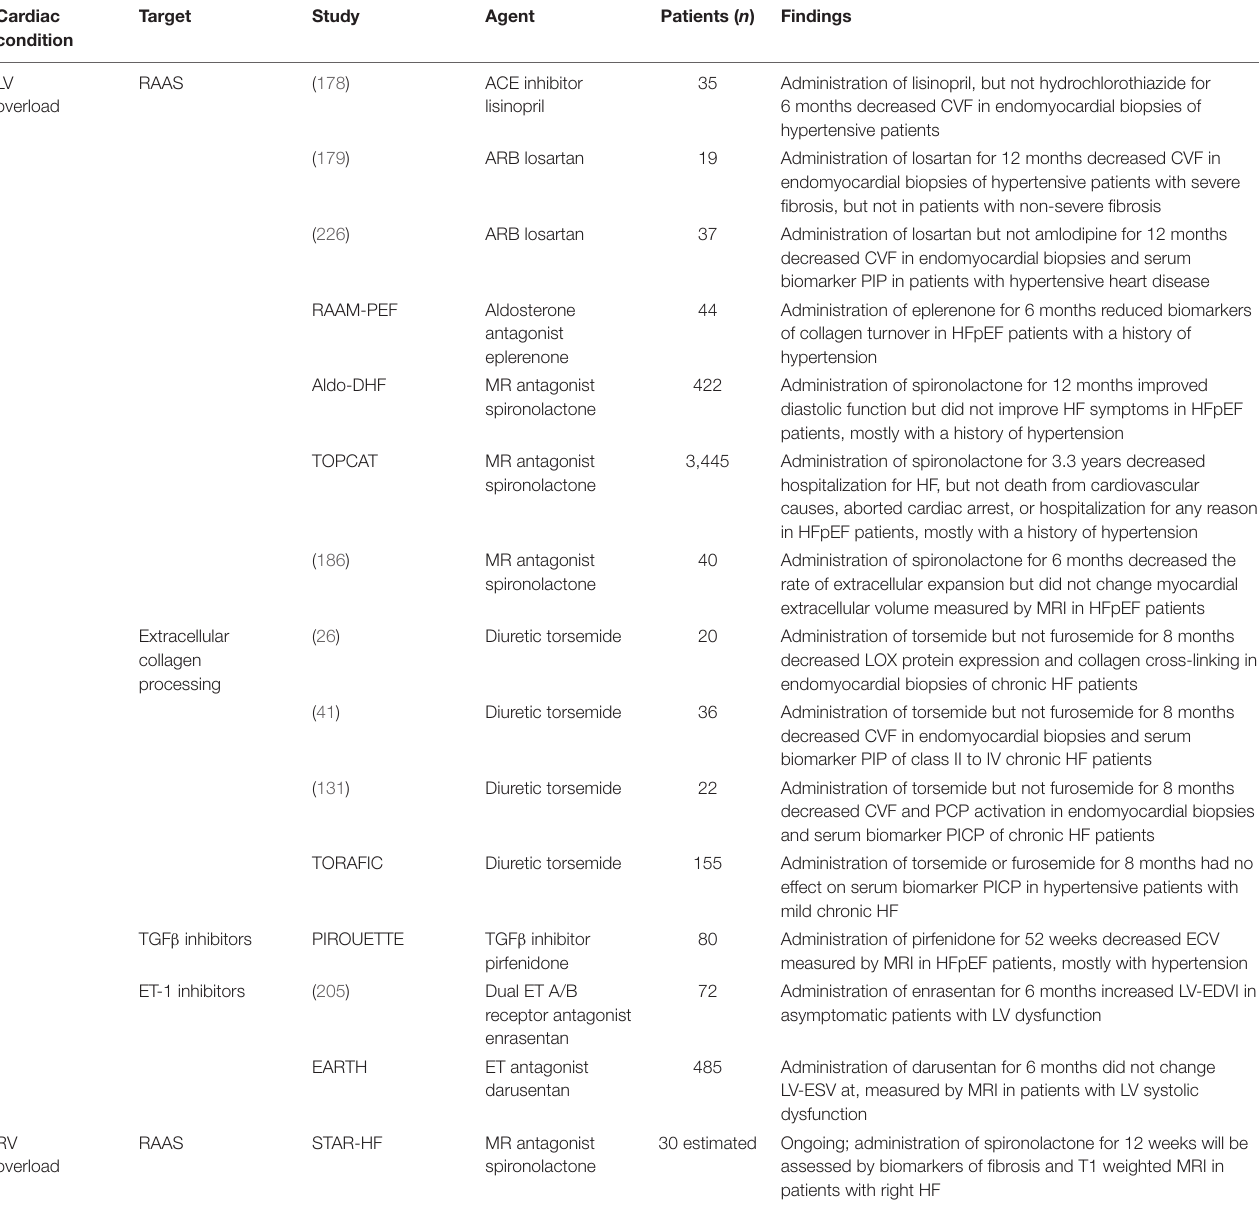
TABLE 1 | HF therapies and agents with the potential to modulate receptors present on cardiac fibroblasts or extracellular collagen processing in clinical testing for LV and RV overloaded conditions. Cardiac